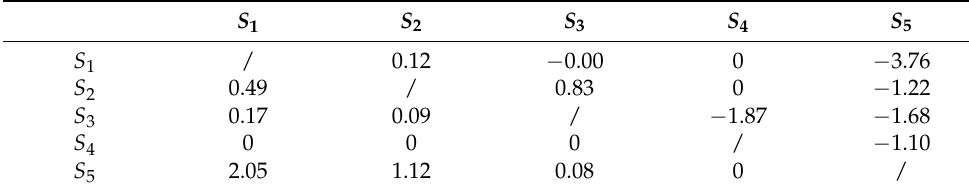
Table 2. Values of test statistic (cid:98) S ij .